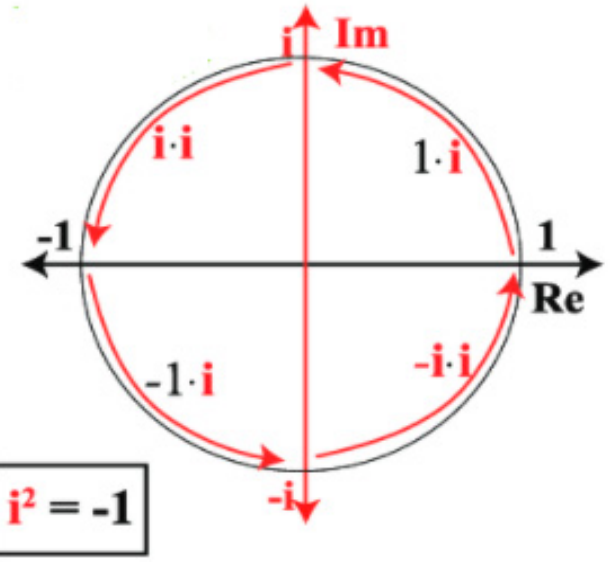
vector power scaler are discussed below. The graphical expressions of the unit disc are explained in Figure 1.